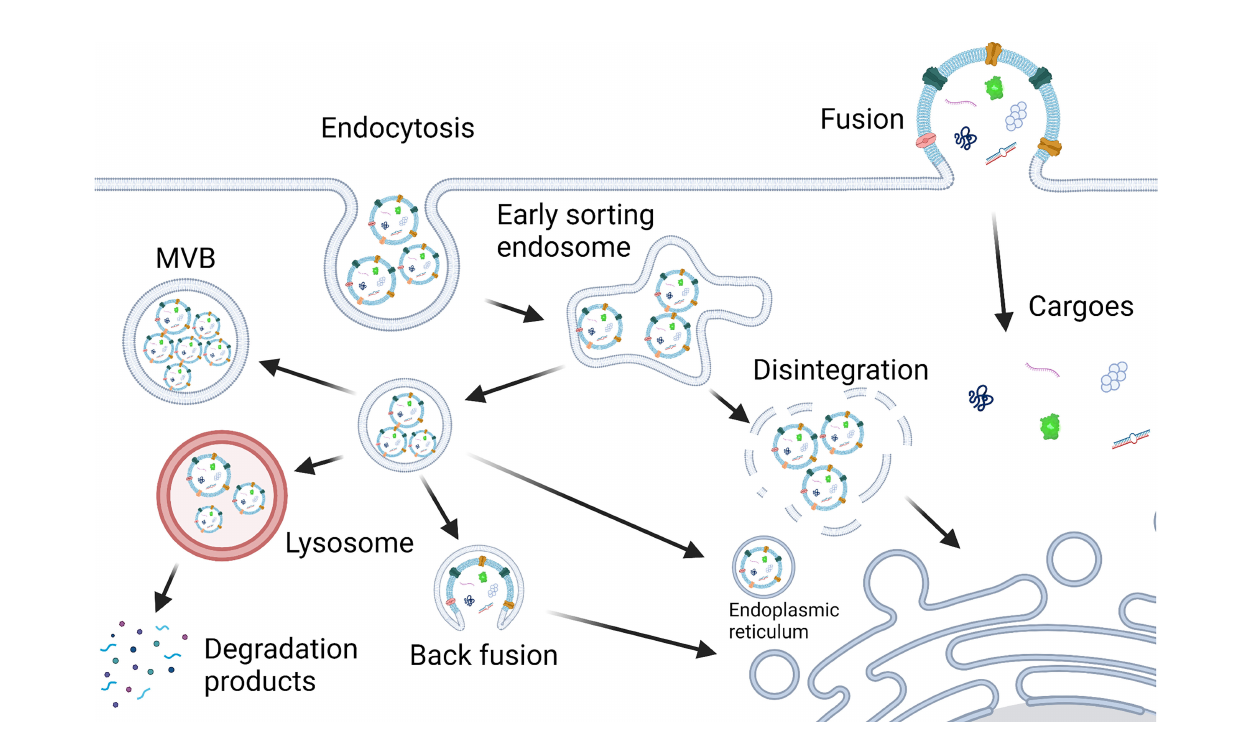
FIGURE 3 | Scheme of PELNs internalization in mammalian cells and cargo release. Mammalian cells take up PELNs possibly through endocytosis and fusion. Cargoes in PELNs can be released into the cytoplasm in different ways, i.e., fusion with the lysosome, the disintegration of the early sorting endosome, and fusion with the endoplasmic reticulum, endosomal membrane and plasma membrane (22, 64). Created with